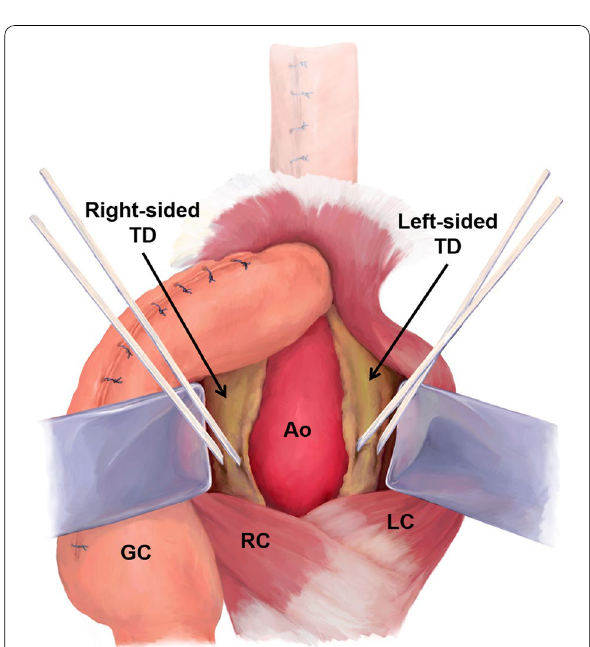
Fig. 3 Illustration of the thoracic duct ligation. TD thoracic duct, RC right crus of the diaphragm, LC left crus of the diaphragm, Ao aorta, GC gastric